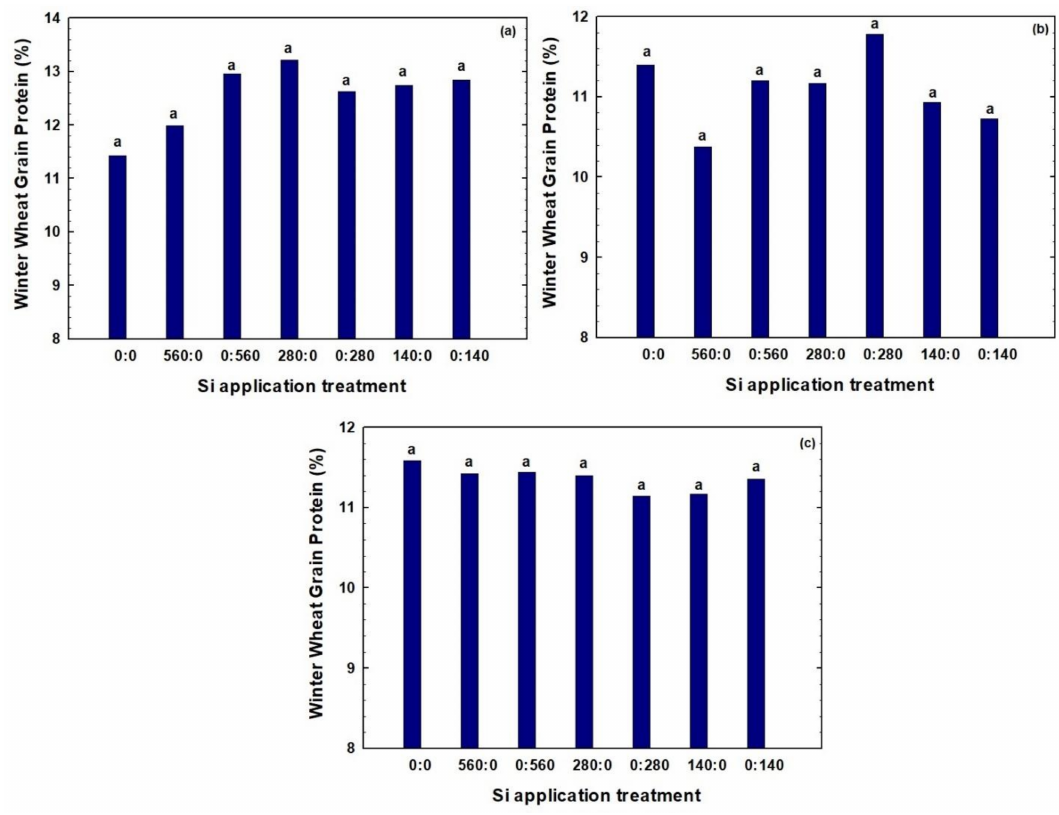
Figure 4. Effect of different Si rates and application time on winter wheat grain protein in ( a ) Field E1 in 2016, ( b ) Field M2 in 2016, and ( c ) Field A3 in 2017. Treatments are designated in the format x:y, in which x and y are the fertilizer Si rates in kg Si ha − 1 applied at planting and at tillering, respectively. Bars within the same year followed by the same letter are not significantly different ( p > 0.1) based on a Duncan’s multiple range